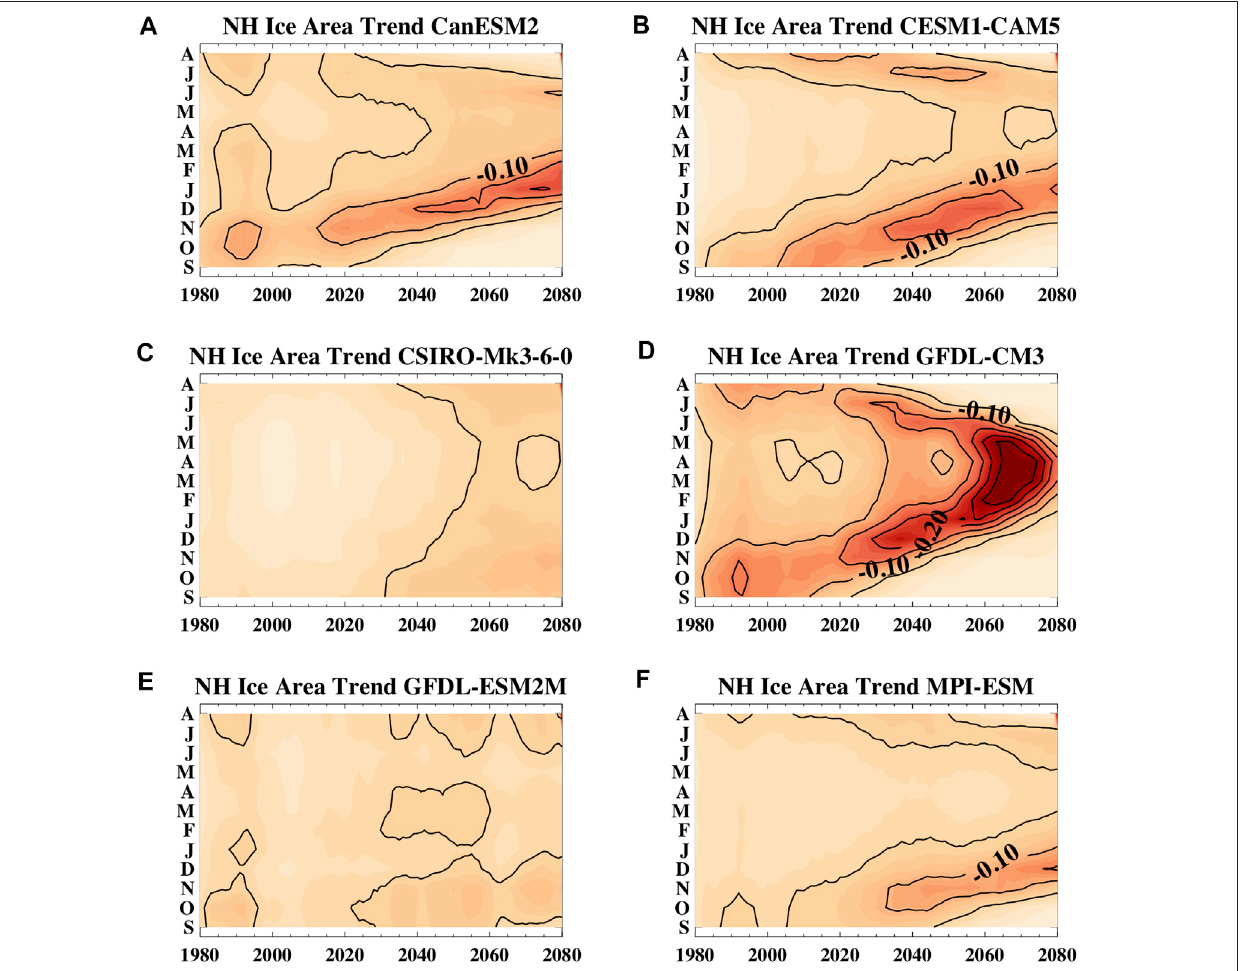
FIGURE 11 | The 20-years running trend of Northern Hemisphere ensemble mean sea ice area for the different models as a function of month and year for (A) CanESM2, (B) CESM1-CAM5, (C) CSIRO-Mk-3-6-0, (D) GFDL-CM3, (E) GFDL-ESM2M,and (F) MPI-ESM.Thelinedcontourintervalis0.05million km 2 per year.Note that as in Figure 12 , the y -axis runs from September on bottom through August on top. Sea ice data was not available for EC-Earth and so that model is not shown.